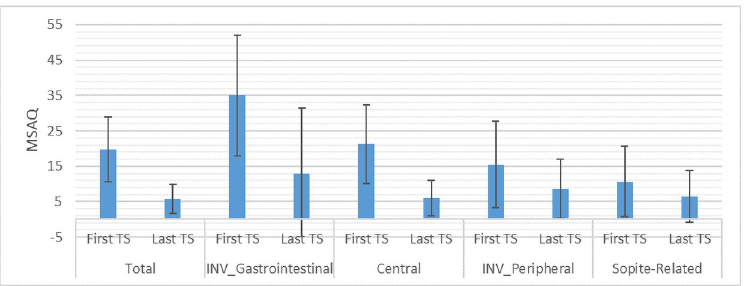
Fig 6. Mean and SD of subcategories of MSAQ for the first and the last training sessions. The prefix INV- indicates outcomes that needed transformation to comply with the normal distribution condition.